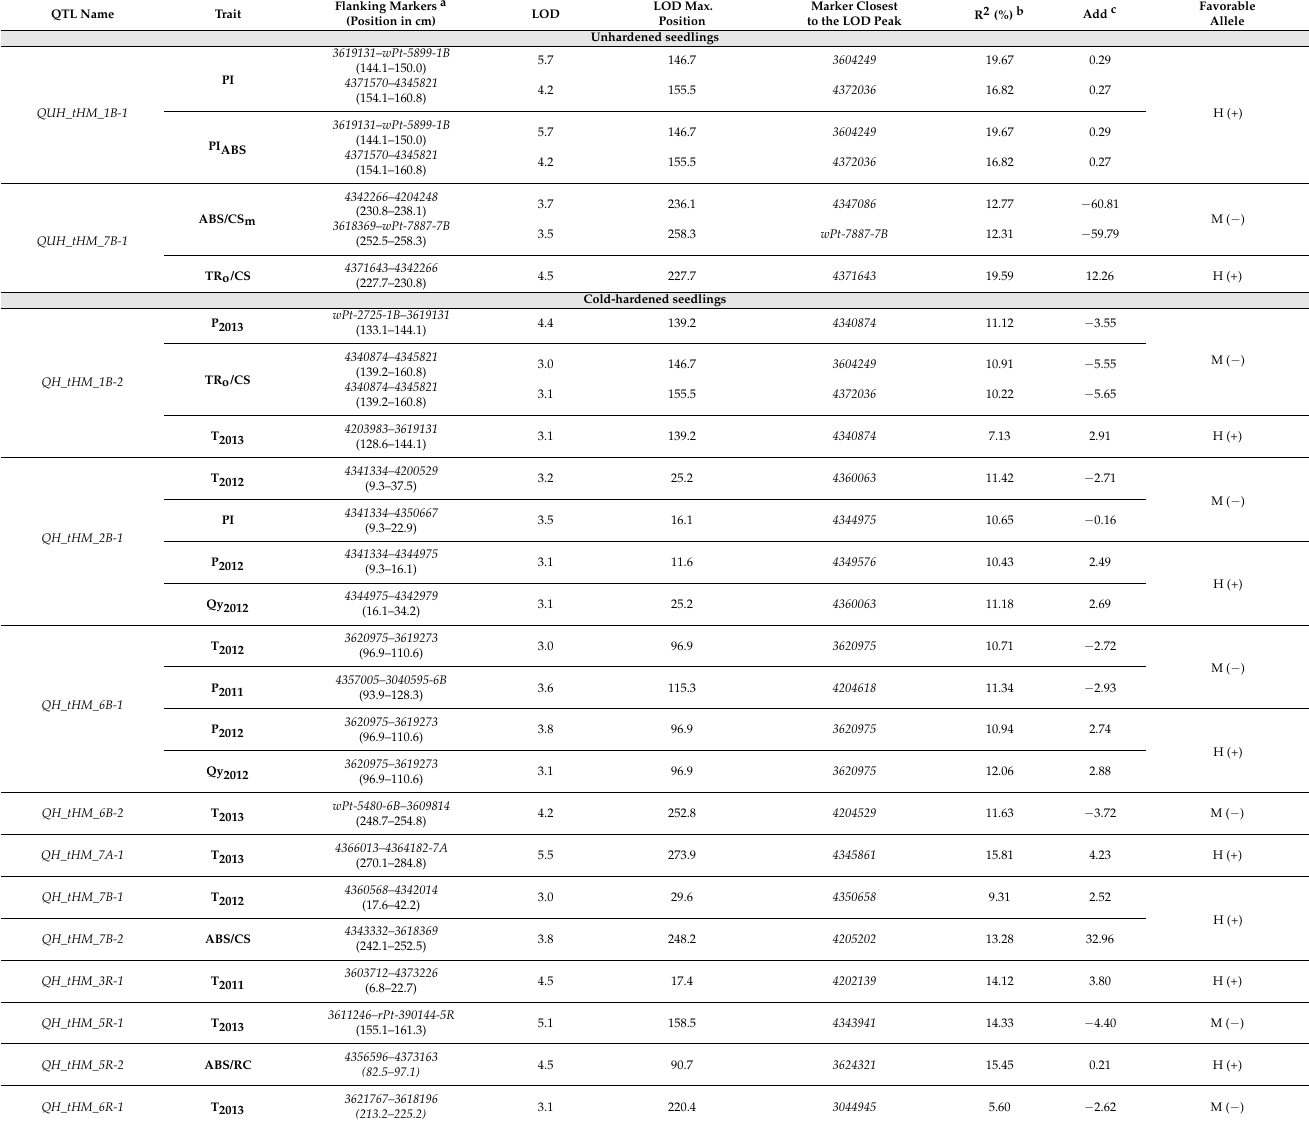
Table 1. The characteristics of the most significant QTLs associated with: (1) the seedling damage caused by the M. nivale infection (P 2011 , P 2012 and P 2013 index); (2) the M. nivale infection tolerance (T 2011 , T 2012 and T 2013 index); (3) photosynthesis quantum efficiency (Qy 2012 ) as well as (4) chlorophyll a fluorescence parameters, identified in unhardened and cold- hardened winter triticale seedlings of the DH ‘Hewo’ x ‘Magnat’ lines mapping population ( a —an identifiable region of the QTL defined by the first and last marker of the QTL region; b —the percentage of the phenotypic variance explained by